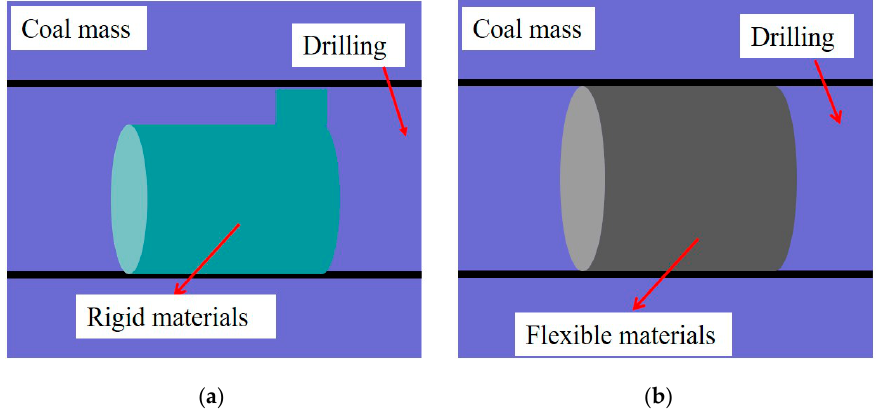
Figure 3. Installation diagram of borehole stress meters with different materials: ( a ) Installation diagram of borehole stress meters with rigid materials. ( b ) Installation diagram of borehole stress meters with flexible